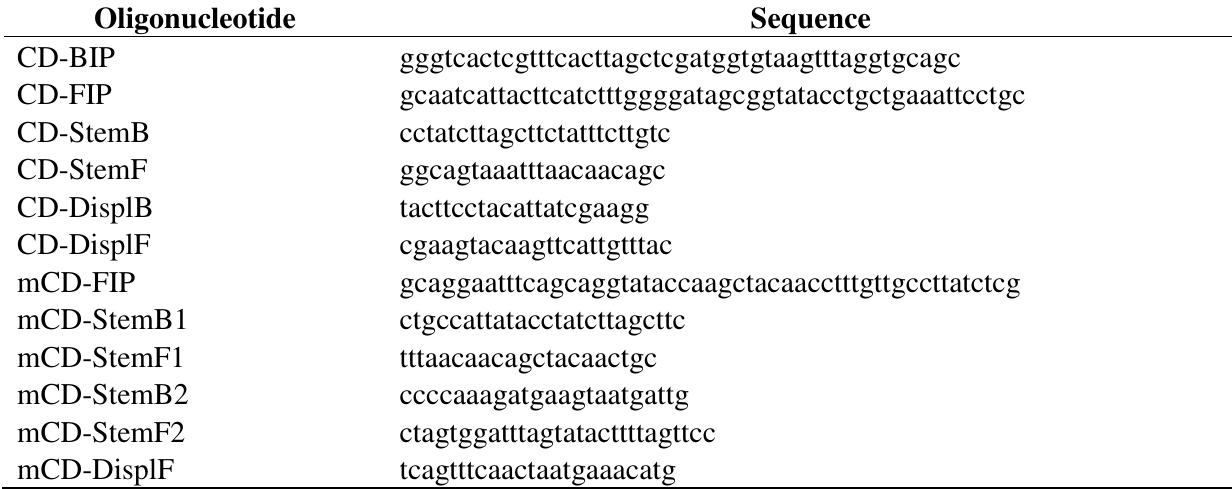
Table 1. Sequences of oligonucleotides designed for Clostridium difficile targeting a toxin B. Oligonucleotide